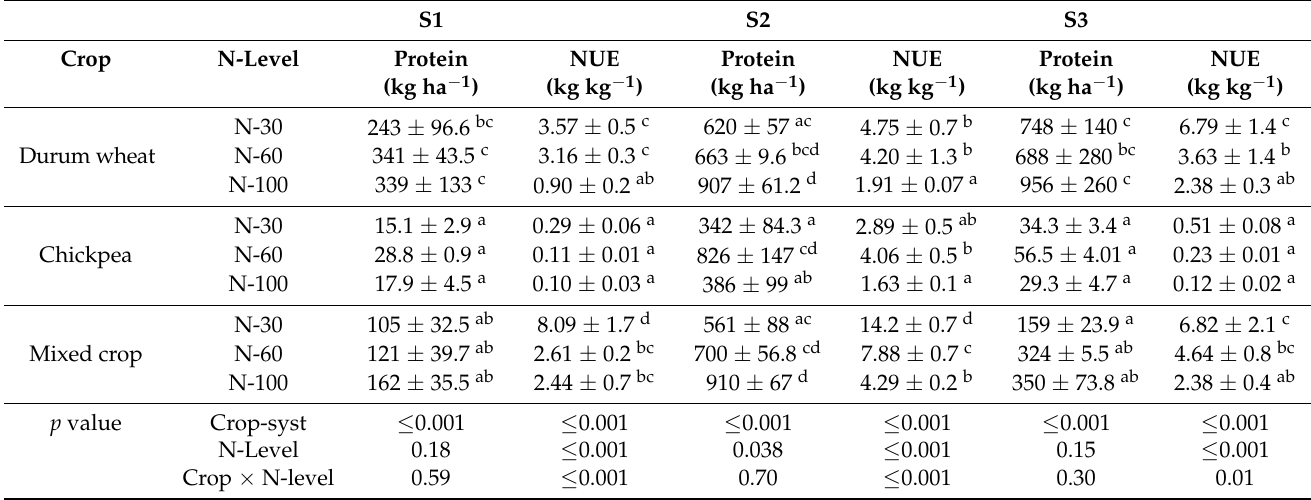
Table 4. Nitrogen use efficiency (NUE) calculated at harvest and protein content in grain yield of chickpea, durum wheat and crop mixture under different crop-N level treatments in the different studied